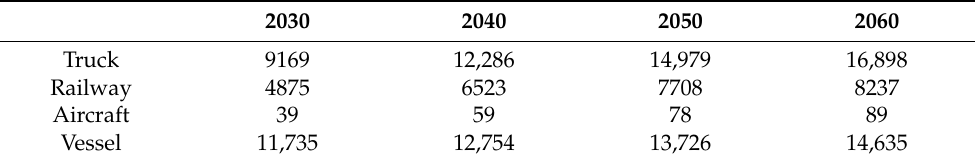
Table 1. Demand for freight transport (billion tonne-kilometres).